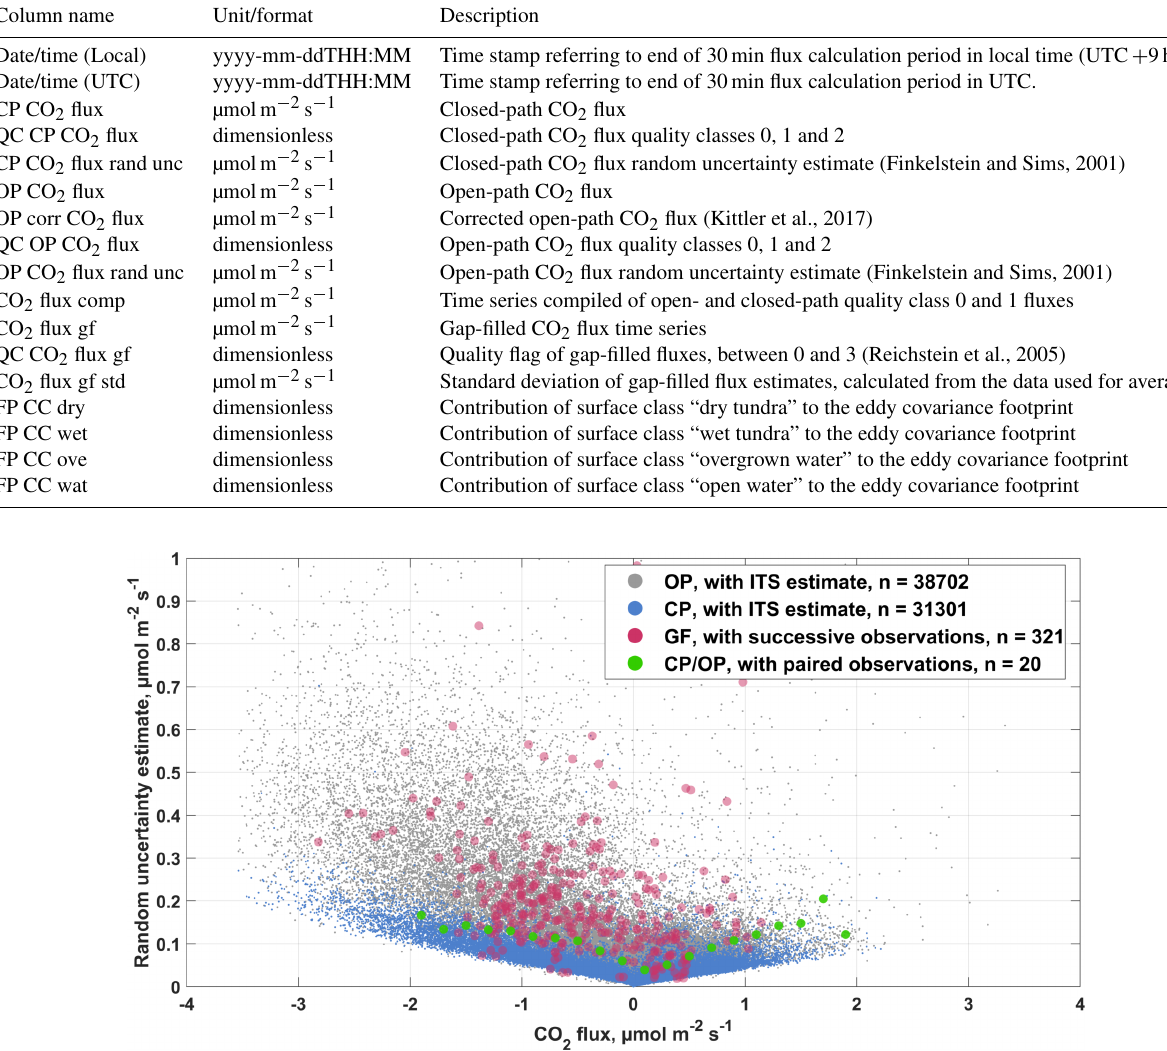
Figure 5. Random uncertainty estimates for all closed-path (CP) and open-path (OP) CO 2 fluxes calculated using estimates of the integral turbulence timescale (ITS), the successive-observations approach and results from gap filling (GF), and the paired-observations approach during periods with simultaneous OP and CP